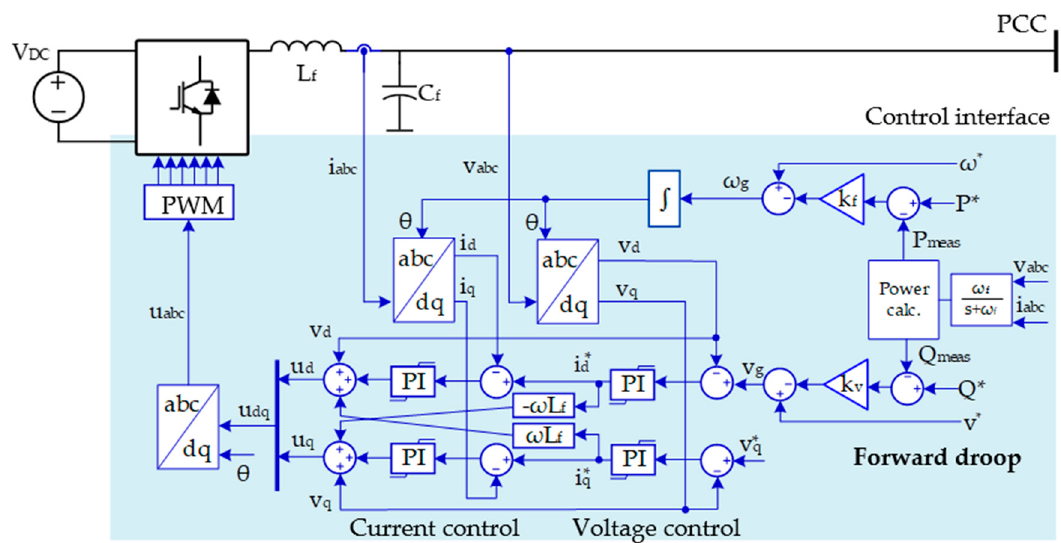
Figure 10. Basic implementation of grid-forming droop control according to [33].